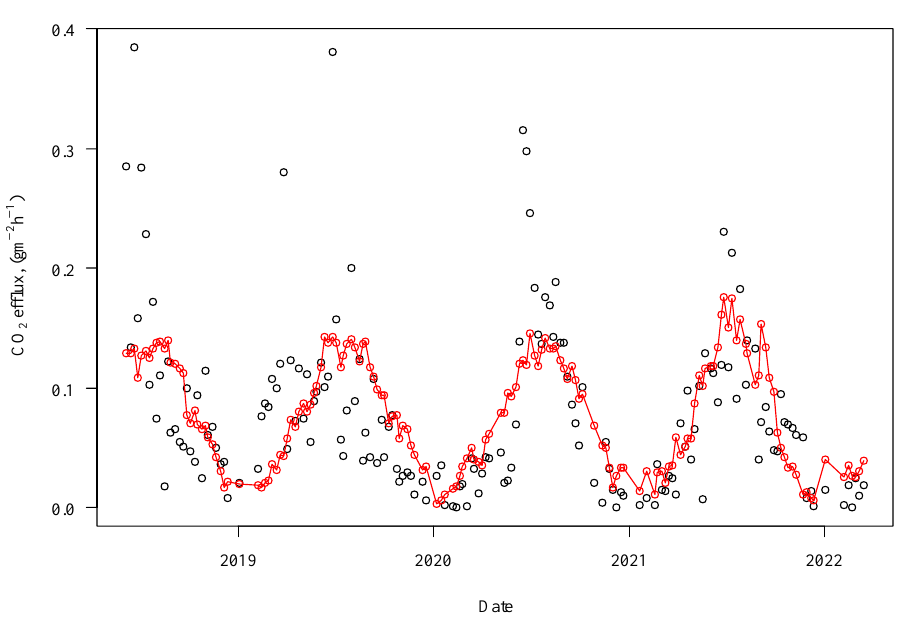
Table 3. Parameters of the quadratic exponential model describing the effect of soil temperature on the CO 2 efflux from undisturbed bare soil under field conditions in Karcag, Hungary. Constant Estimate Standard Error t Value Pr (>| t |) 0.0285905 0.0511563